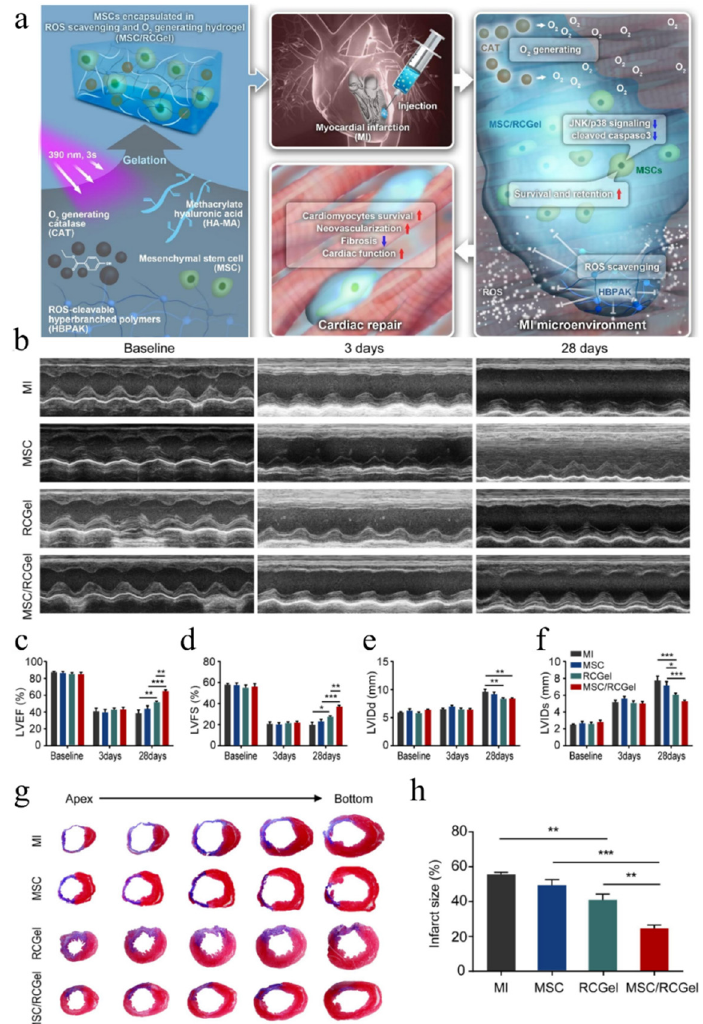
Figure 4. ( a ) Scheme of mesenchymal stem cells-loaded ROS-scavenging and O 2 -generating hydro- gel (MSC/RCGel) for MI treatment. ( b ) Representative echocardiography images, and quantitative analysis of ( c ) left ventricular ejection fraction (LVEF), ( d ) left ventricular fractional shortening (LVFS), ( e ) left ventricular end diastolic diameter (LVIDd) and ( f ) left ventricular end systolic diameter (LVIDs) before MI (baseline), three days and 28 days after MI. ( g ) Representative Masson’s trichrome staining images in five different sections from the apex to the bottom of the heart 28 days after MI. ( h ) Quantitative analysis of the infarcted size. (Reprinted with permission from Ref. [106]. 2022, Elsevier). Level of significance (*— p < 0.05, **— p < 0.01, ***— p < 0.001)